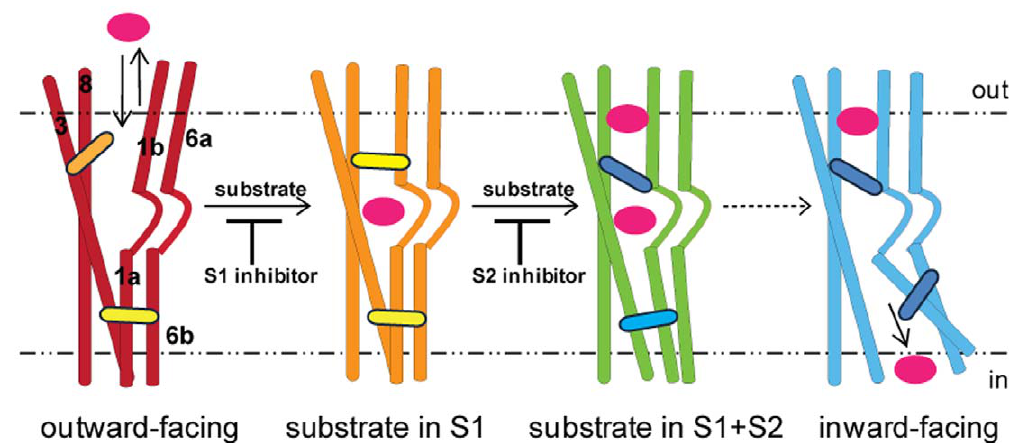
Figure 8. Cartoon model of a substrate translocation cycle for DAT. Substrate binding in the outward-facing model (red) promotes the formation of an occluded conformation (orange). The binding of a second substrate (doubly occupied state in green) induces conformational changes in the S1 site and the intracellular side through conserved interaction networks (colored lozenges) positioned between the S2 and S1 sites, which reorganize the interaction network at the intracellular end, eventually leading to the release of substrate in the S1 site from the inward-facing conformation (cyan). Inhibitors that bind to the S1 site block the formation of S1,S2-DAT and thus the translocation. Inhibitors that bind to the S2 site inhibit the release of S1 and act as translocation de-couplers